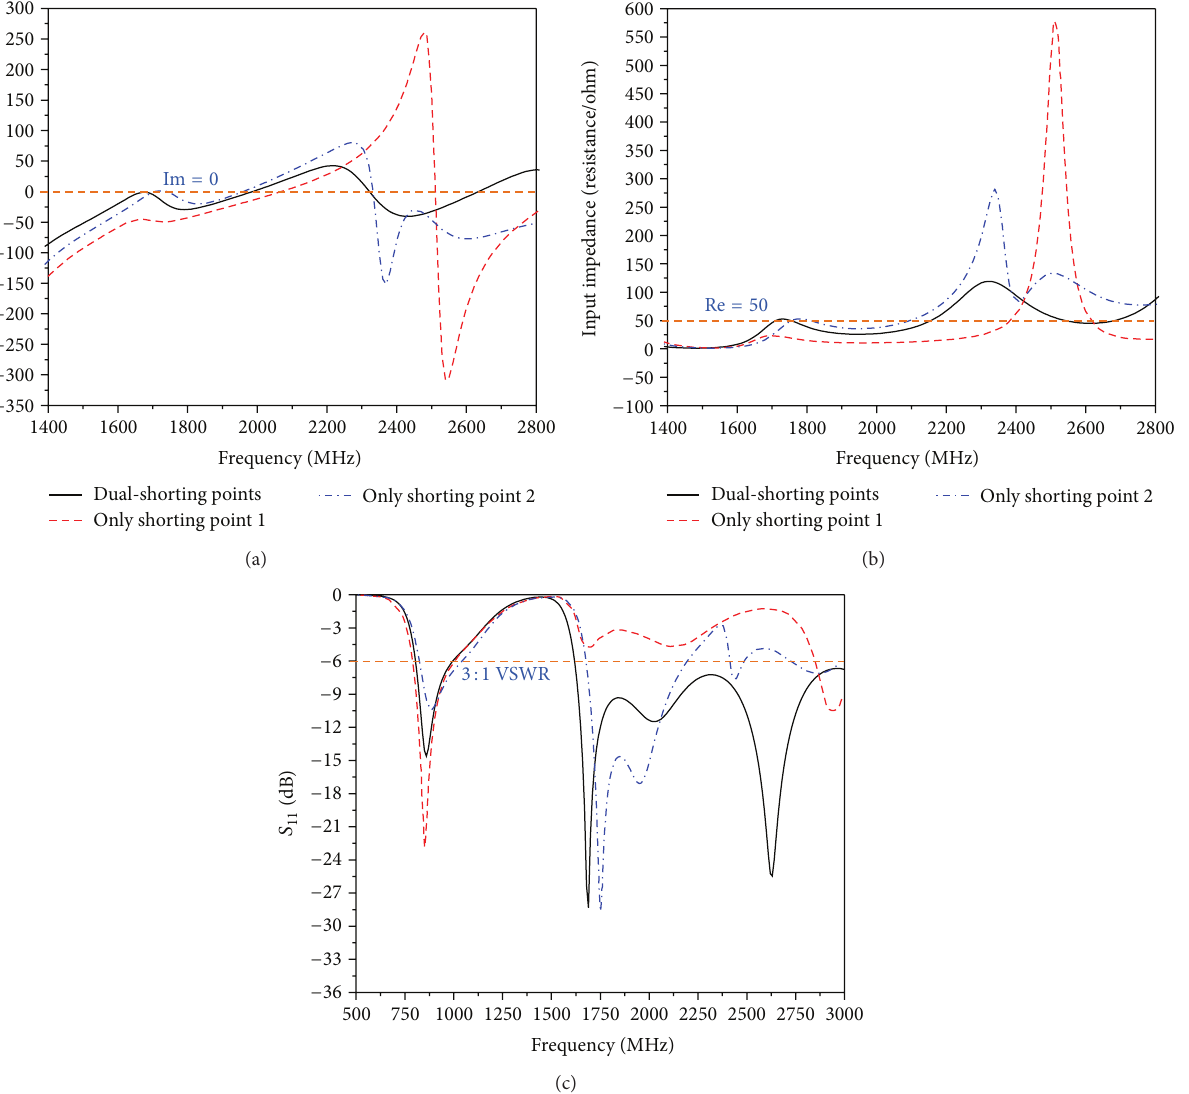
Figure 3: Simulated results with shorting points 1 and 2: (a) input impedance (reactance), (b) input impedance (resistance), and (c) 𝑆